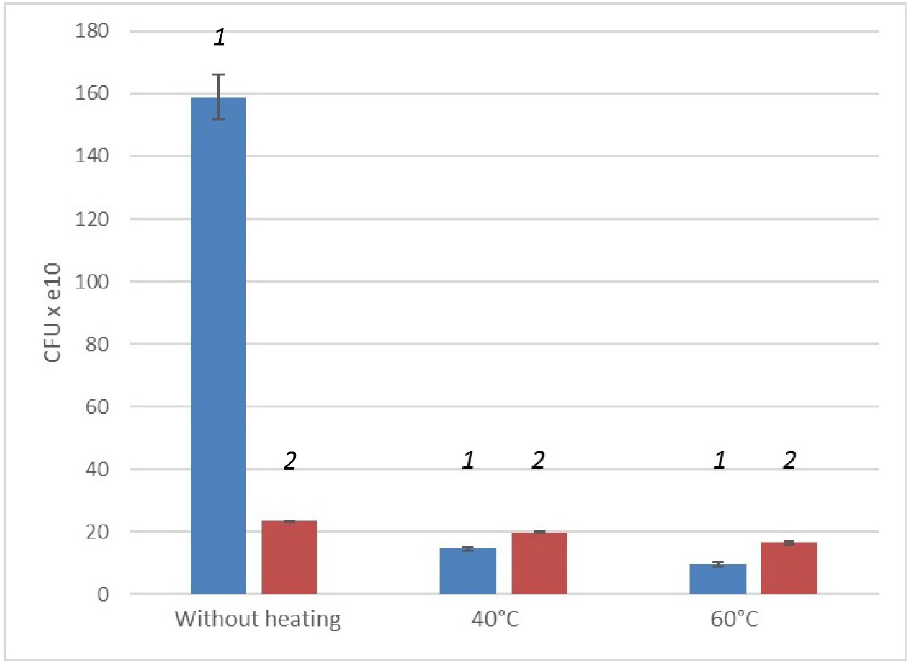
Figure 2. Change in CFU values of a three-day (1) and two-month (2) cultures of G. polyisoprenivorans 135 cells under heating.